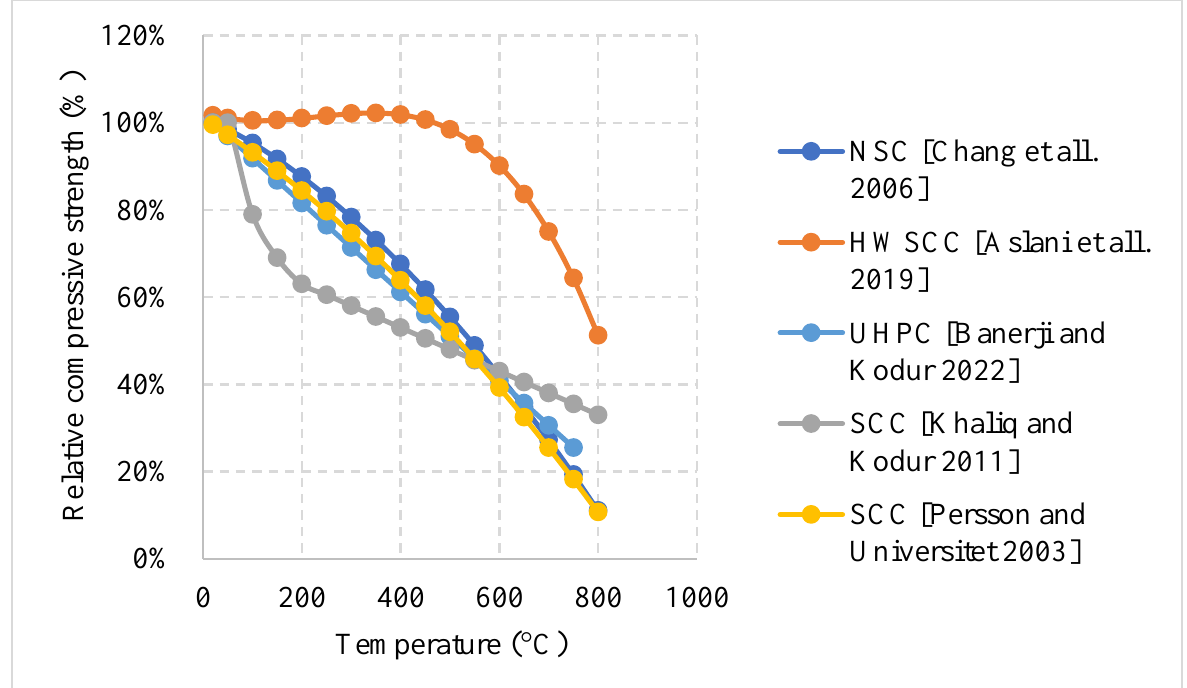
Figure 47. Relative compressive strength models for different types of concrete [48,75,97,108,135].